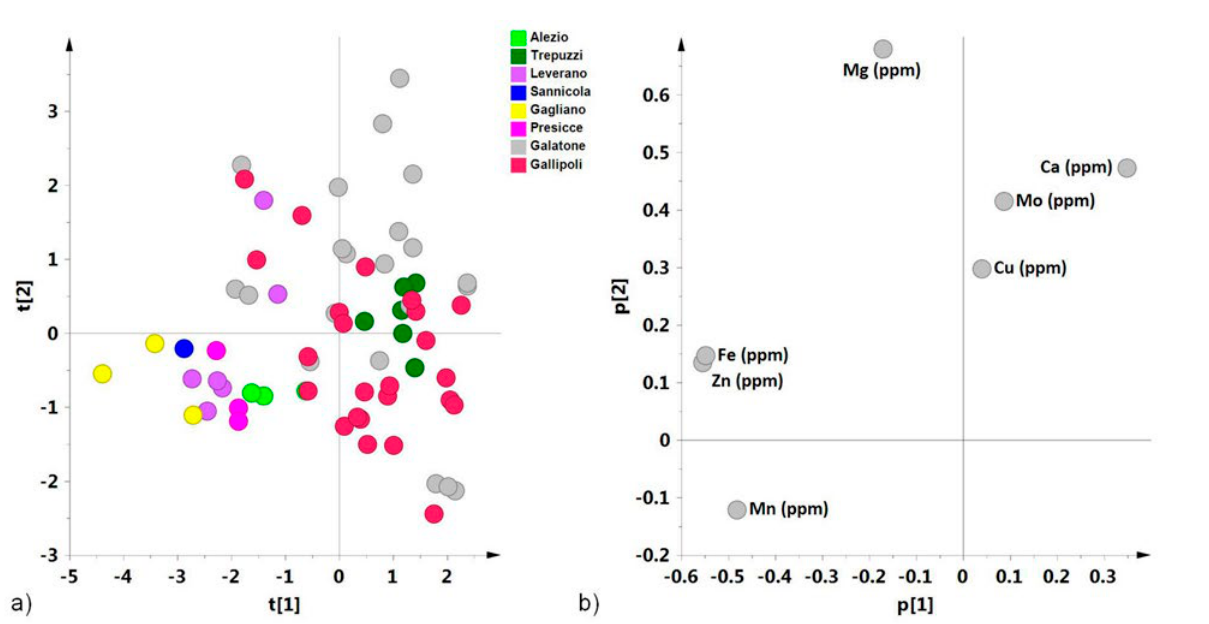
Figure 1. Principal component analysis for soil samples collected from different sites in the Salento area (Southern Apulia). t[1]/t[2] score- plot (a) and corresponding p[1]/p[2] loadings plot (b). Two principal components (t[1]/t[2]) explained about 60% of total variance (R 2 = 0.37 for t[1] and 0.18 for t[2]), with a predictability value of Q 2 =